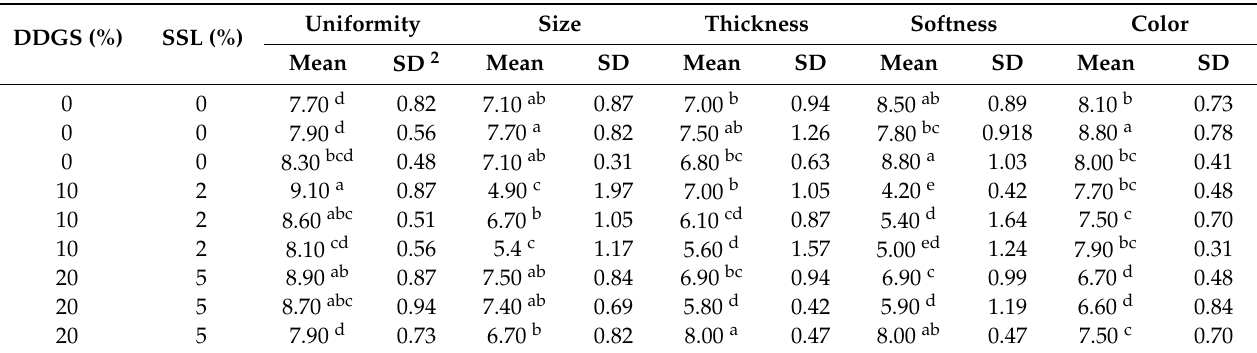
Table 12. Treatment effects on quality evaluation parameters 1